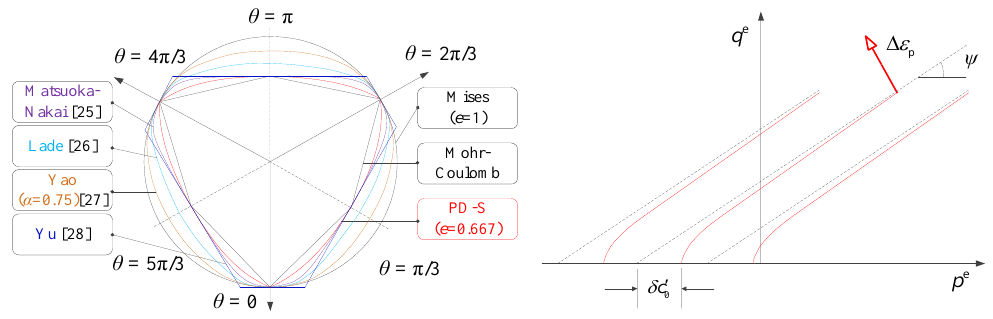
Figure 6. Shape of yield surface in deviatoric plane and meridian plane.